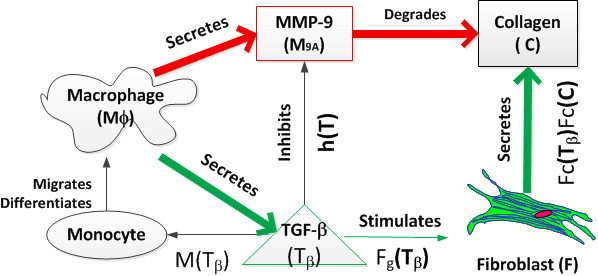
A working model of post-MI scar formation and remodeling with constructive and destructive modules. Red arrows represent the destruction pathway and green arrows represent the construction pathway. The regulation scheme includes lines in black, which can be a driving or a triggering stimulus. LV remodeling outcomes are denoted as collagen concentrations in the scar tissue.